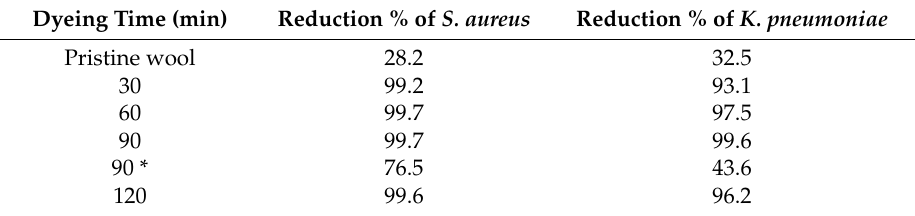
Table 4. Antibacterial activity of wool fabrics dyed with spent coffee extract at 90 ◦ C as a function of dyeing time (all dying samples were mordanted with 1 wt % tannic acid aqueous solution except 90*